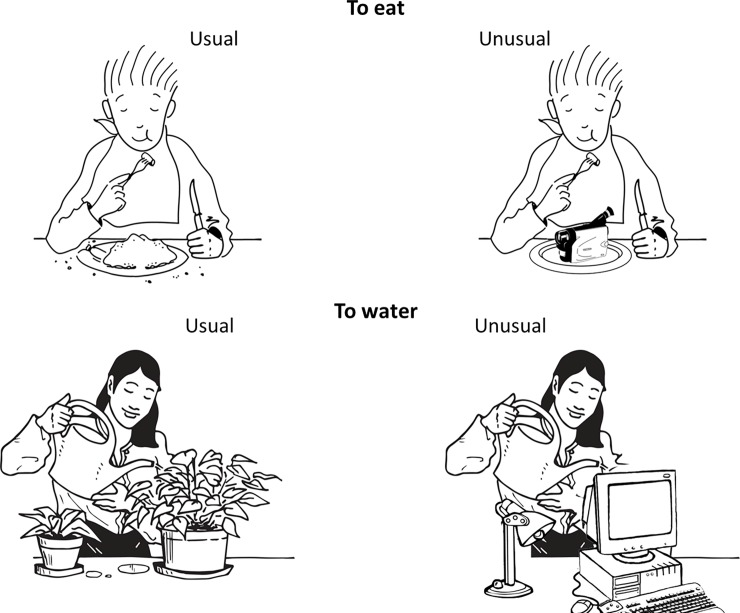
Examples of usual and unusual pictures used in the experiment.Usual actions have been selected in the French database Clic images 2.0 which proposes royalty-free illustrations (see Clic-Image2-0 –Réseau Canopé http://www.cndp.fr/crdp-dijon/clic-images/). Unusual actions have been built from the same model of character but were modified.